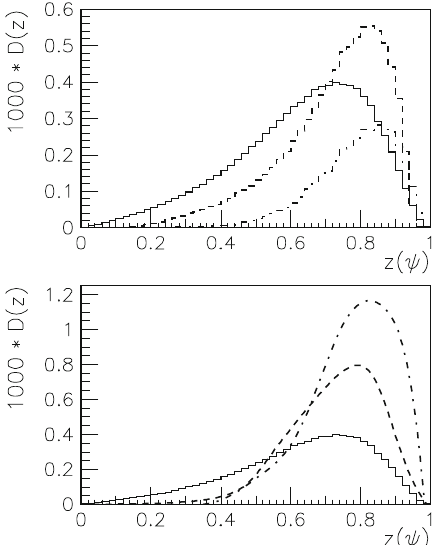
Fig. 2 Effective c → ψ fragmentation functions derived from differ- entpartonicsubprocesses:solidcurve, e + e − → γ ∗ → ψ c ¯ c ,calculated withEq.(3).Othercurvesarecalculatedfor g g → ψ c ¯ c asisdescribed in Sect. 3. The following restrictions are set on the J /ψ transverse momentum and on the fragmenting quark momentum p ∗ = P ψ + p c > 20 (see details in Sect. 2.3): dashed curves, p ψ T > 20 GeV, p ∗ T > 50 GeV. Upper plot GeV; dash-dotted curves, p ψ T > 50 GeV, p ∗ T corresponds to the collinear scheme with MSTW gluon densities [22]; lower plot, k t -factorization with A0 gluon densities